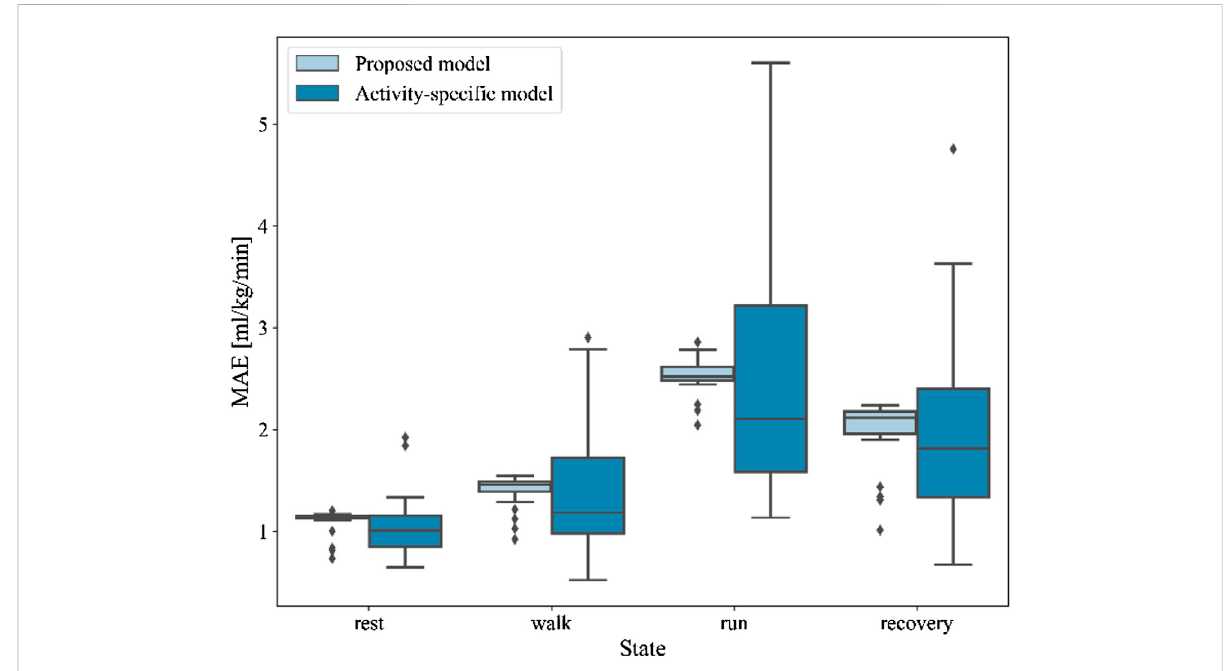
FIGURE 4 The boxplot of MAE of the proposed model and activity-speci fi c model in different